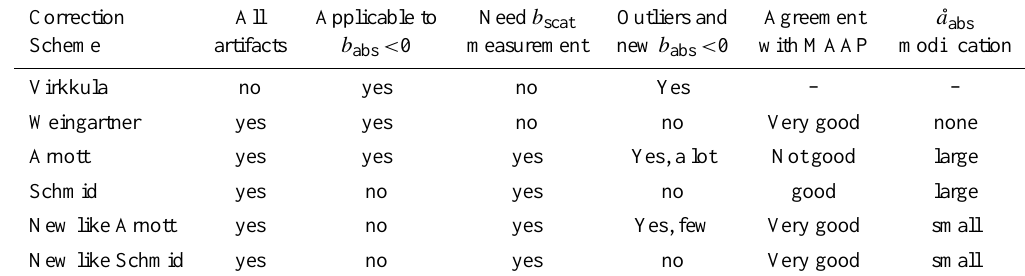
Table 6. Evaluation of the applicability and the performance of AE corrections based on the criteria defined under Sect. 4.1. Correction All Applicable to Need b scat Outliers and Agreement ˚ a abs Scheme artifacts b abs < 0 measurement new b abs < 0 with MAAP modification Virkkula no yes no Yes Weingartner yes yes no Arnott yes yes Schmid yes New like Arnott